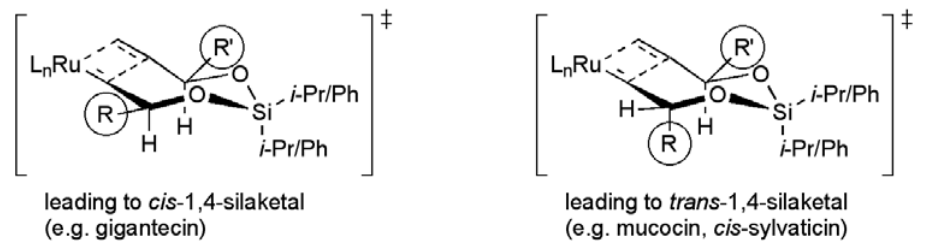
Figure 19. Diastereoselective tethered RCM reactions of